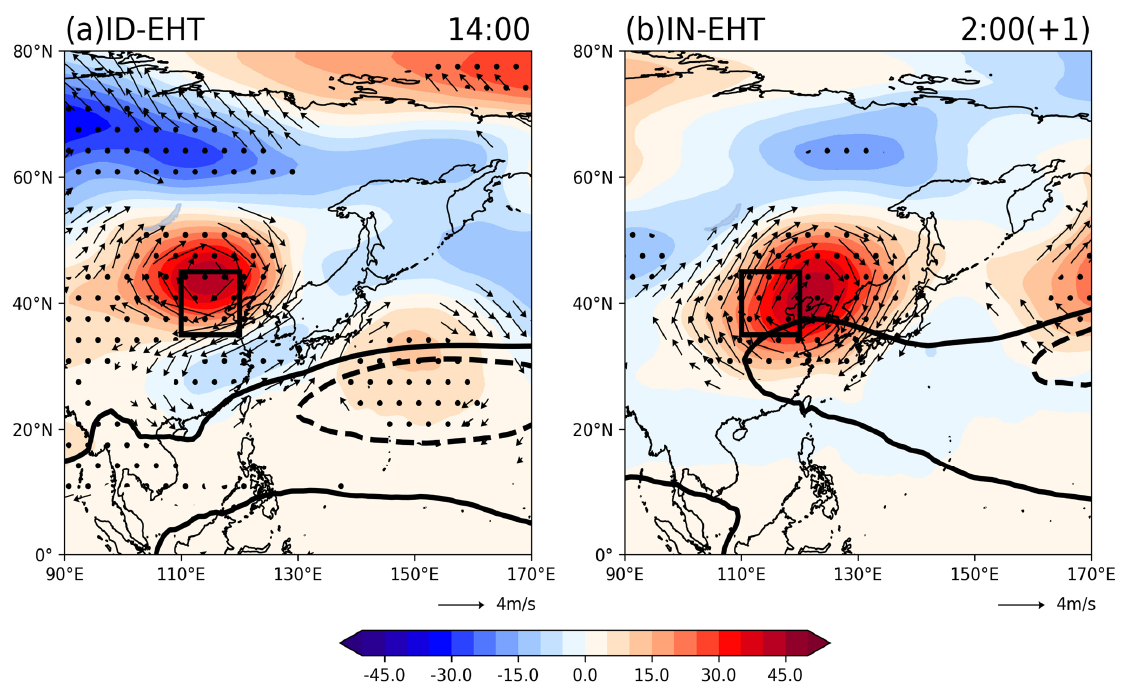
Figure 7. Composite anomalies of 500 hPa wind (arrows; units: m/s) and geopotential height (shading; units: m) at 14:00 ( a ) on the day for ID-EHT and at 2:00 ( b ) on the next day for IN-EHT. The black solid and dotted contours represent the WPSH domain (depicted by geopotential height of 5860 and 5880 m); Only wind anomalies that are significant at the 95% confidence level are retained.